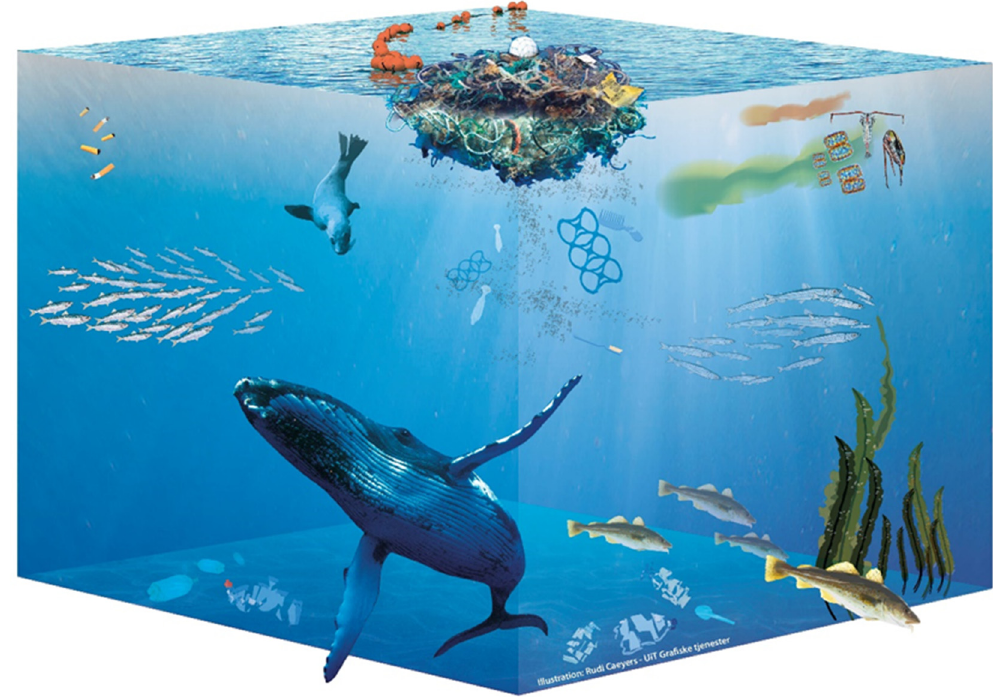
Figure 4. Plastic as a wicked problem, affecting the marine ecosystem as a whole. Illustration by Rudi Caeyers for SECURE, UiT Grafiske tjenester, 2021.